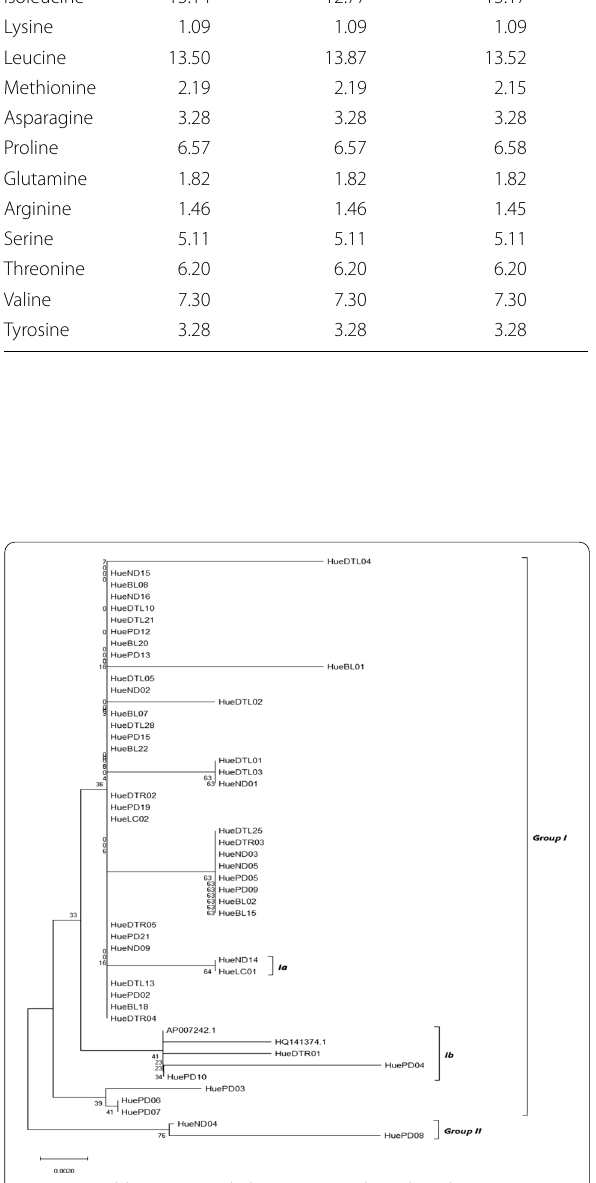
Fig. 2 Neighbor-joining phylogenetic tree based on the COI nucleotide